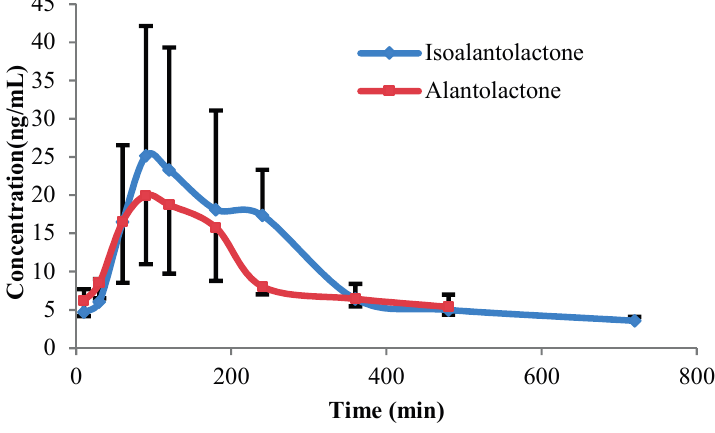
Figure 3. Plasma concentration-time profiles of isoalantolactone and alantolactone following oral administration in rats at doses of 90 mg/kg Radix Inulae extract ( n =